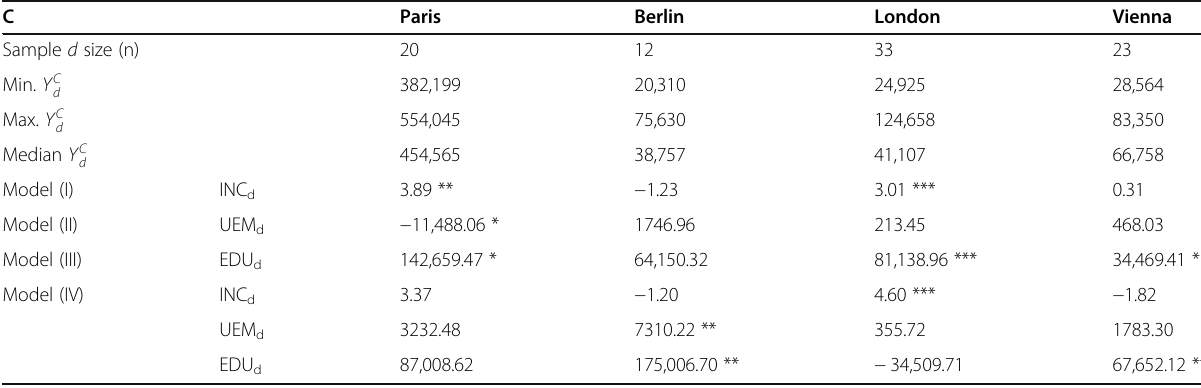
Table 2 Summary of city regression tables for four models on C